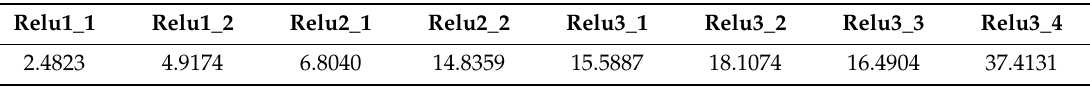
Table 1. L2 loss value of feature matrix of remote sensing image and electronic map in VGG-19 part network layer.